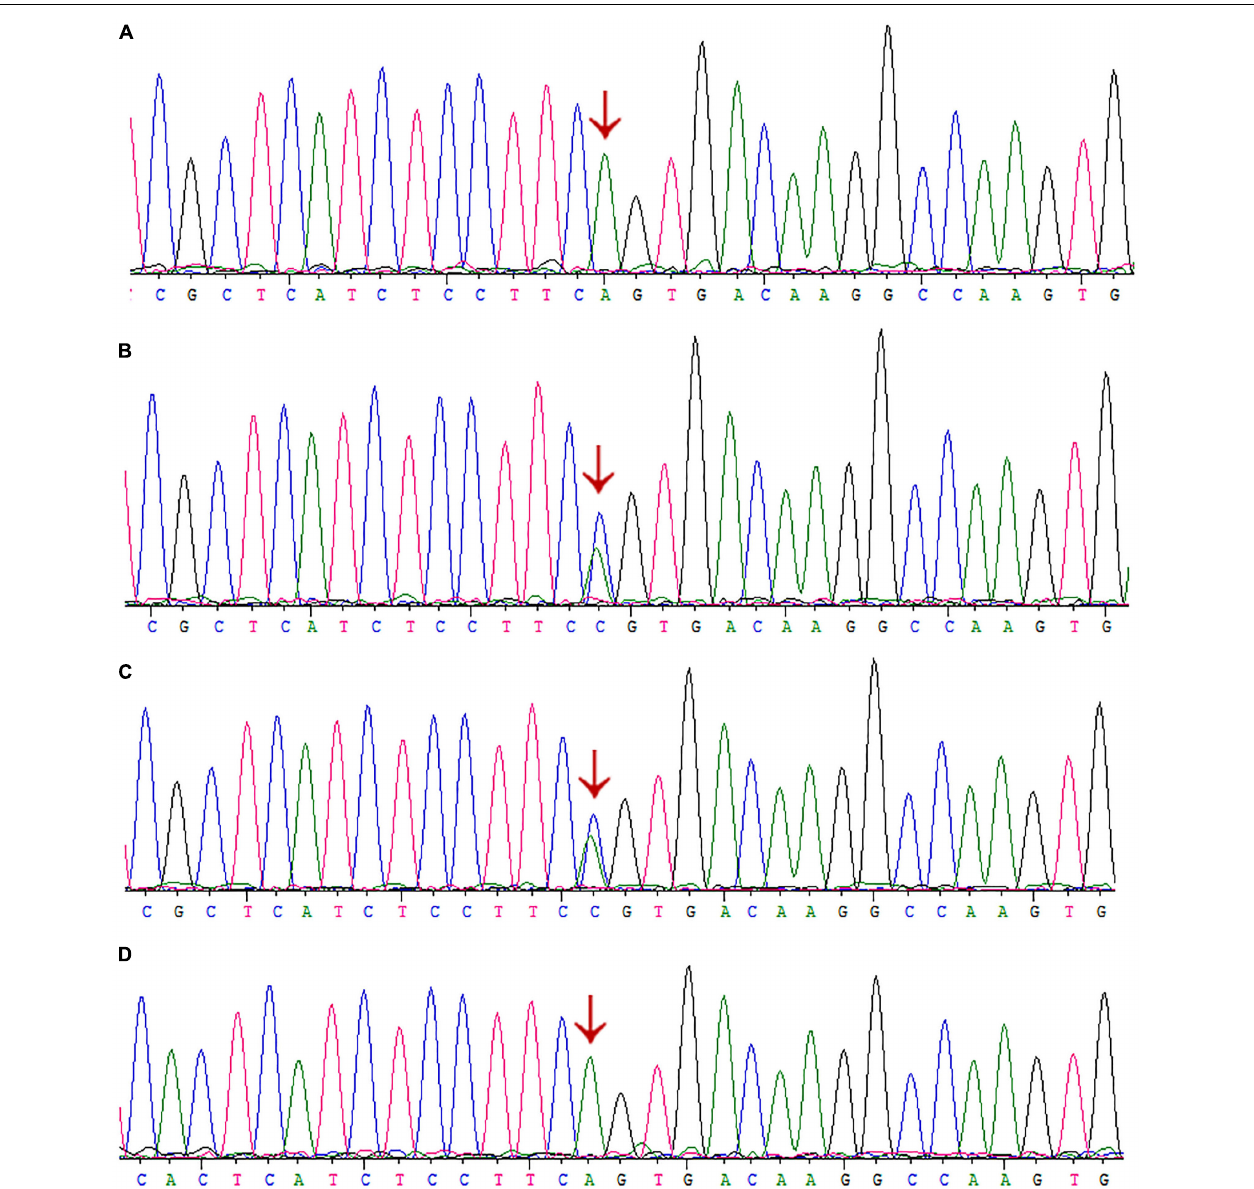
FIGURE 5 | Sanger sequencing of AGXT-exon6 c.667A>C/S223R mutation by different primers. (A) Exon 6 of III:3 was PCR-amplified using the primer AGXT6F/AGXT6R and Sanger sequenced using the AGXT6F as the sequencing primer. (B) Exon 6 of III:3 was PCR-amplified using the primer 2AGXT6F/2AGXT6R and Sanger sequenced using the 2AGXT6F as the sequencing primer. (C) 2AGXT6F/2AGXT6R-amplified fragments Sanger-sequenced by AGXT6F. (D) AGXT6F/AGXT6R-amplified fragments Sanger-sequenced by